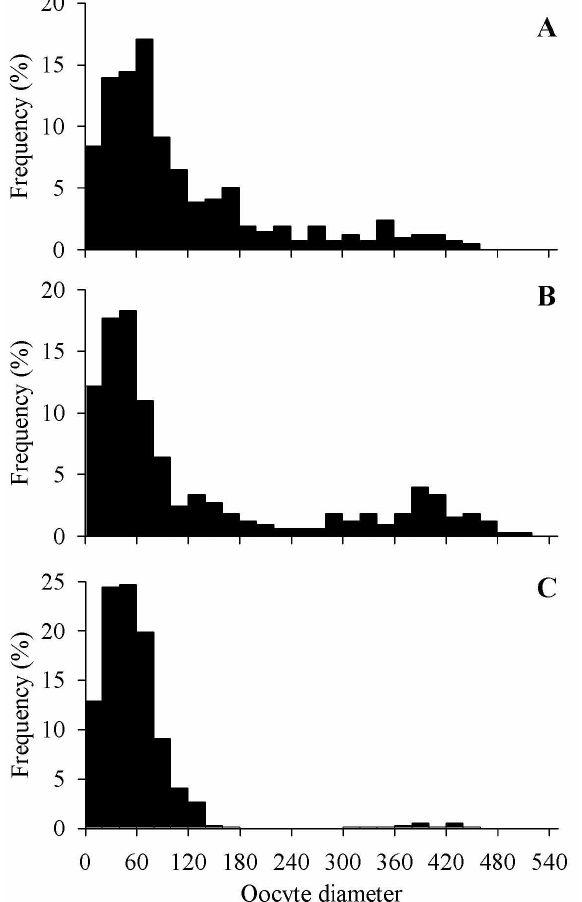
Fig . 8. – Size frequency distribution of oocyte diameter grouped per 20 m m from histological sections of 3 Epinephelus marginatus females . A: a 69.5 cm TL female captured in the middle of June, maturity stage 4, B: a 64.7 cm TL female captured in the middle of July, maturity stage 6; C: a 63.5 cm TL female captured at the end of August, maturity stage 6. Number of oocytes measured A: 416, B: 328, C: